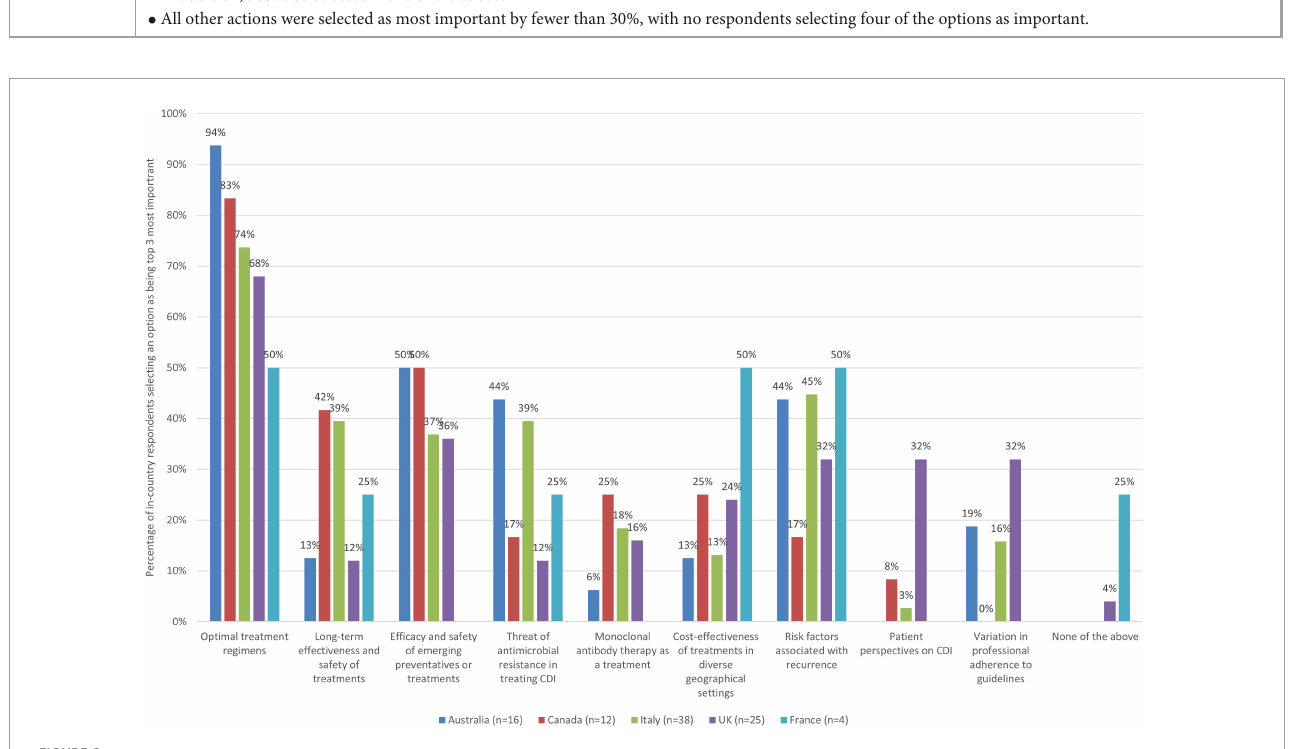
FIGURE6 The 3 evidence gaps in relation to CDI that are the most important to address by